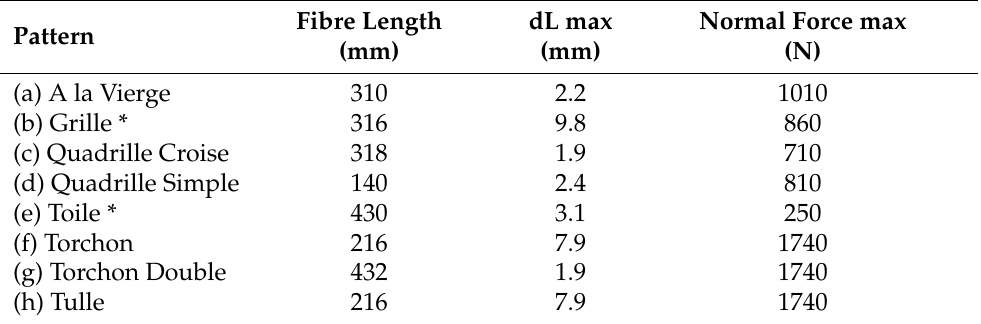
Figure 7. Setup of digital simulations. From left to right: ( a ) A la Vierge, ( b ) Grille, ( c ) Quadrille Croise, ( d ) Quadrille Simple, ( e ) Toile, ( f ) Torchon, ( g ) Double Torchon. Cyan shows compression and red shows tension members. Table 2. Results of digital simulations (Samples are 10 × 20 mm swatches, and material properties used are not based on flax fibre. Patterns marked with an asterisk are not considered for implementa- tion in tailored lace